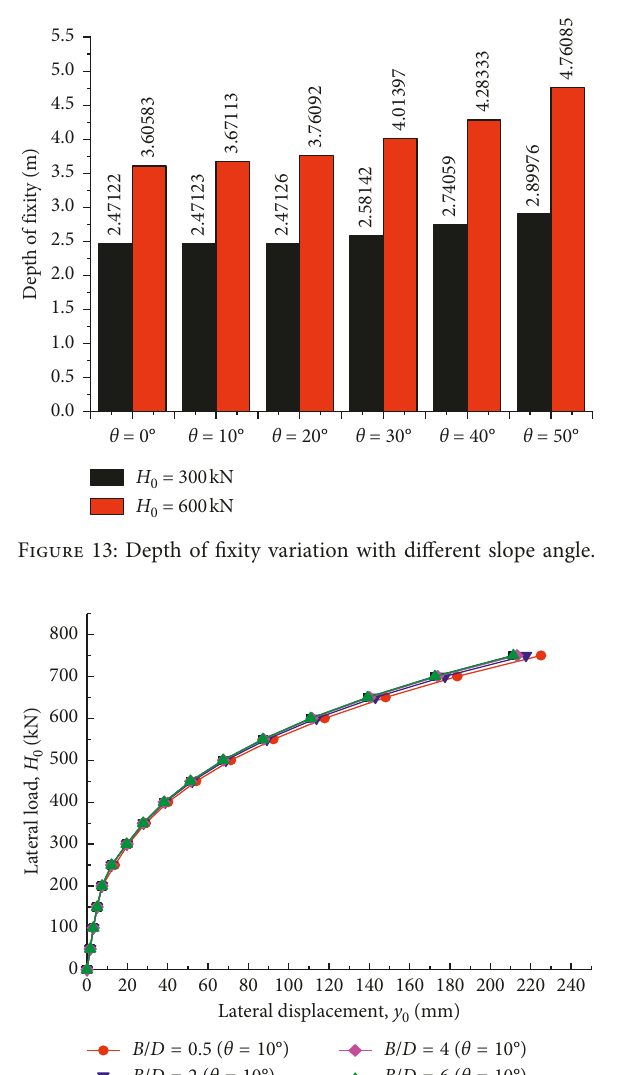
Figure 17: Bearing capacity of pile head for different normalized 10 ° for different (cid:31) distance of pile (corresponding to 200mm).